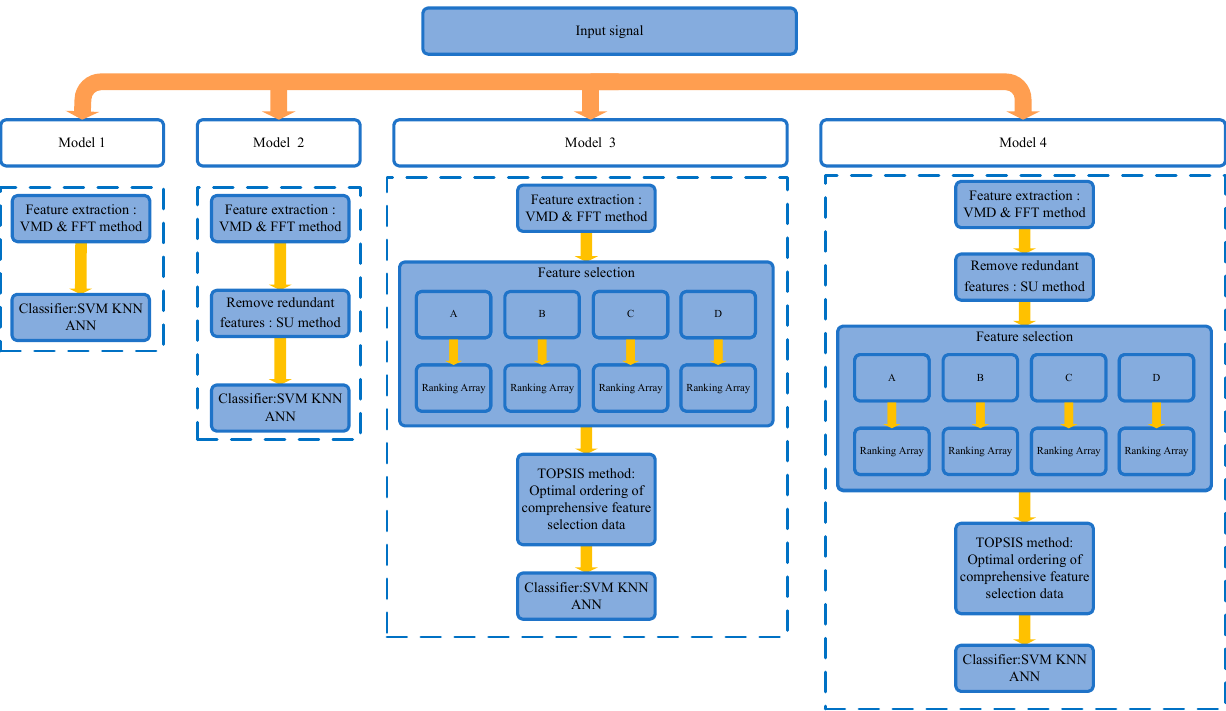
Figure 4. Propose an integrated FFS model fl owchart for optimal feature selection. Model 1 : Using the VMD-FFT feature extraction process and presenting the result with a classi fi er.